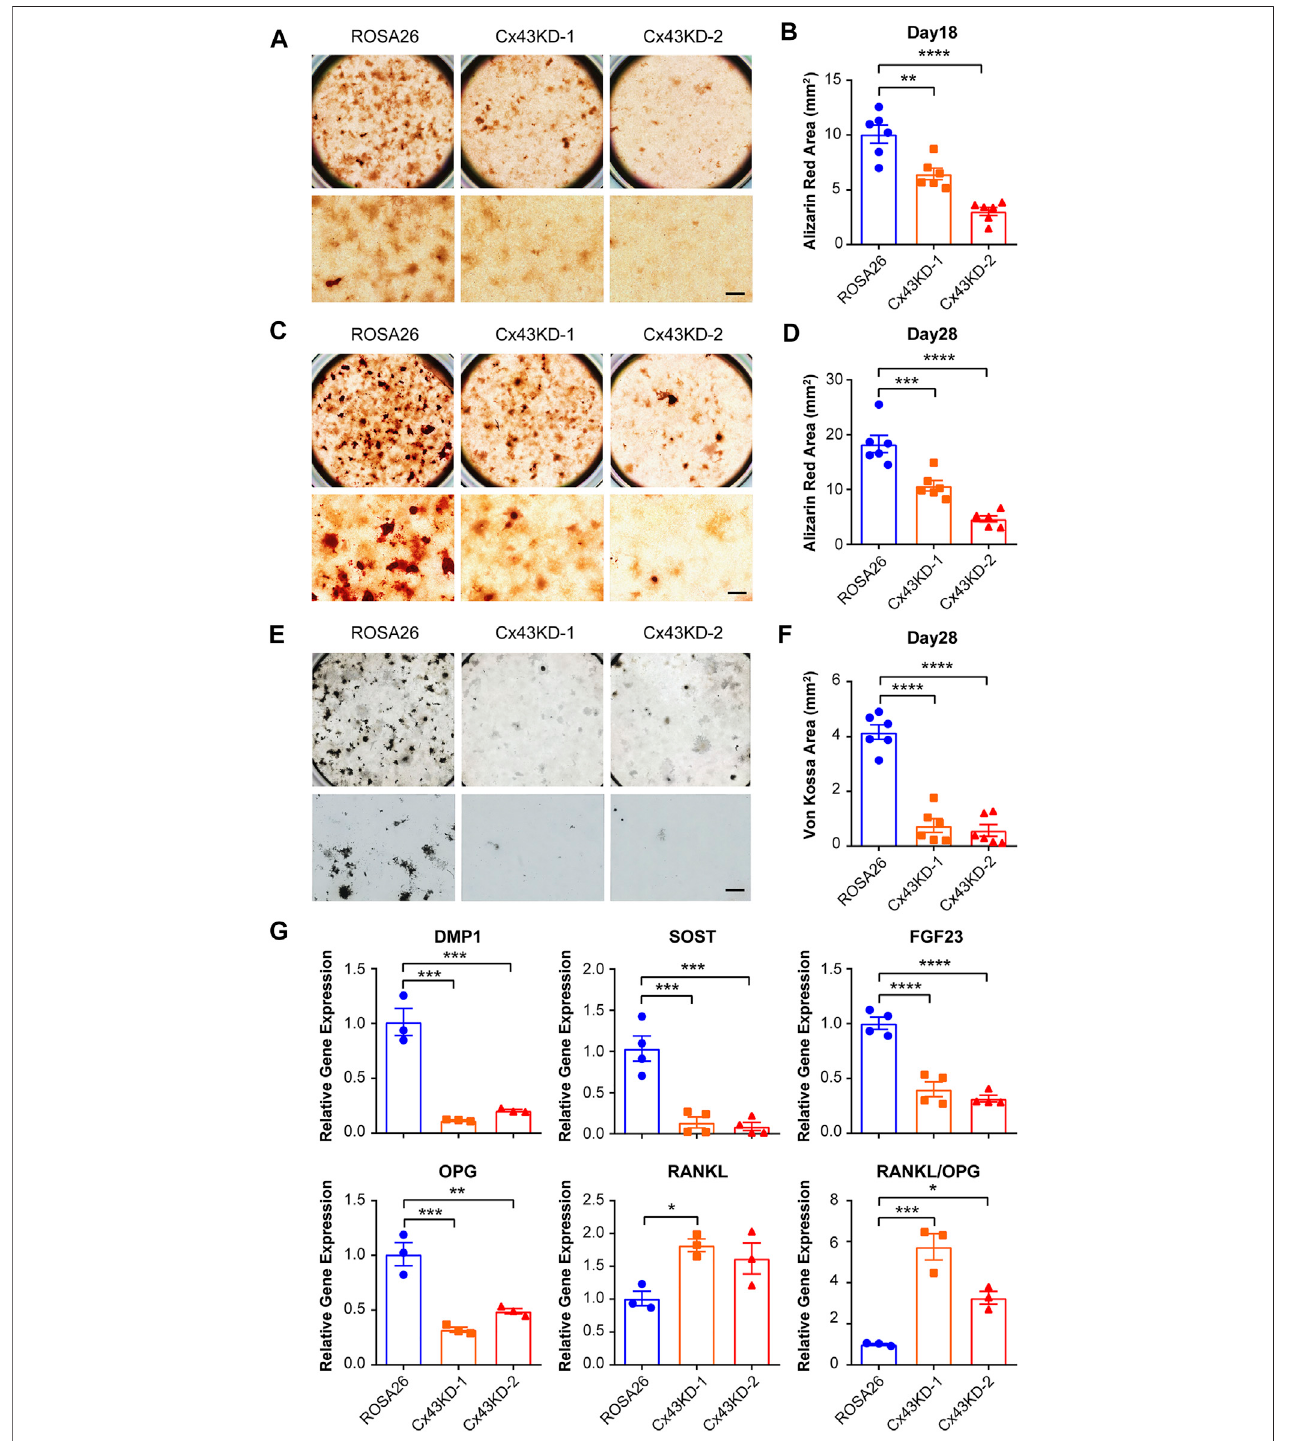
FIGURE5| Cx43knockdowndecreasedmatrixmineralizationandosteocyticmarkersexpression inIDG-SW3cells.RepresentativeimagesofAlizarinred staining in ROSA26 or Cx43 KD IDG-SW3 cells at day 18 (A) or 28 (C) of the induction of differentiation. Lower panels show an enlarged view of the center regions of upper panels. Scale bar, 500 μ m. (B,D) Quanti fi cation of Alizarin red – stained area by NIH ImageJ software. (E) Representative images of von Kossa staining in ROSA26 or Cx43 KD IDG-SW3 cells after 28 days of differentiation. Lower panels show an enlarged view of the center regions of upper panels. Scale bar, 500 μ m. (F) Quanti fi cationof vonKossa -stained areabyNIHImageJsoftware. (G) TotalRNAwaspreparedfromROSA26orCx43KDIDG-SW3cellsafter28daysofdifferentiation. ThemRNAlevelsofDMP1,SOST,FGF23,OPG,andRANKLweredeterminedbyreal-timePCRnormalizedtoGAPDH.Datashownaremean±SEM.*,p < 0.05,**,p < 0.01, ***, p < 0.001, ****, p < 0.0001.